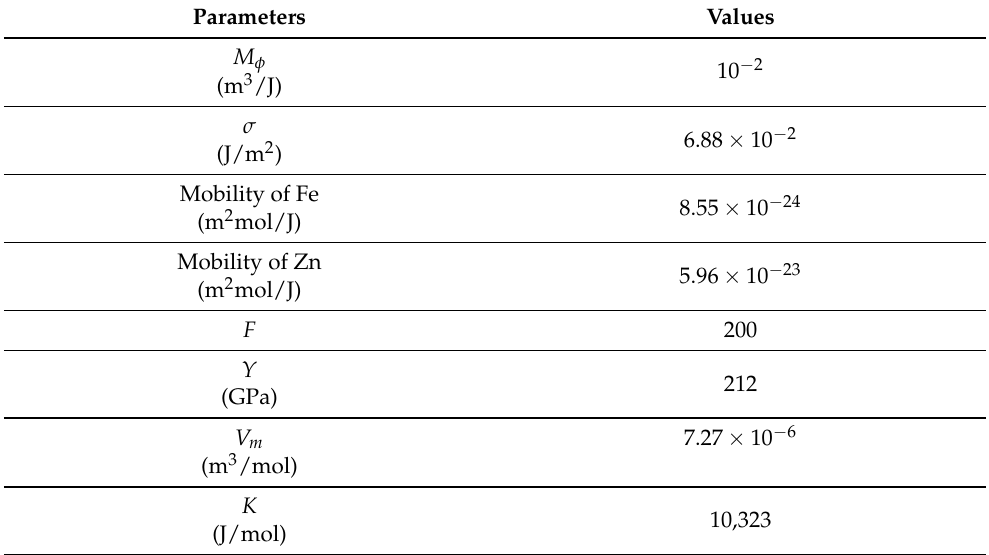
Table 1. Simulation parameters.